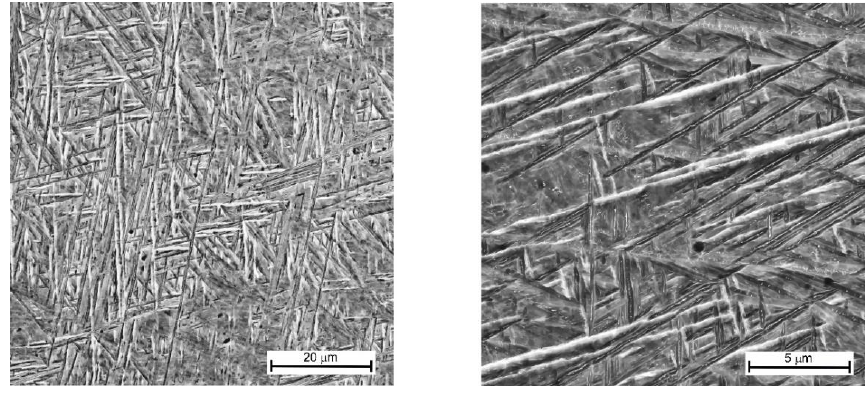
Figure 6. Microstructure of a Ti-6Al-4V buildup obtained by the DLD method.